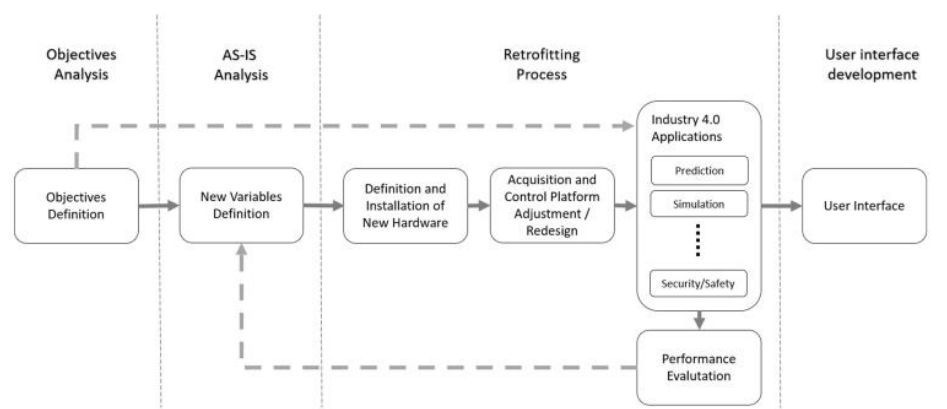
Figure 6. Approach adopted for the retrofitting process [61].